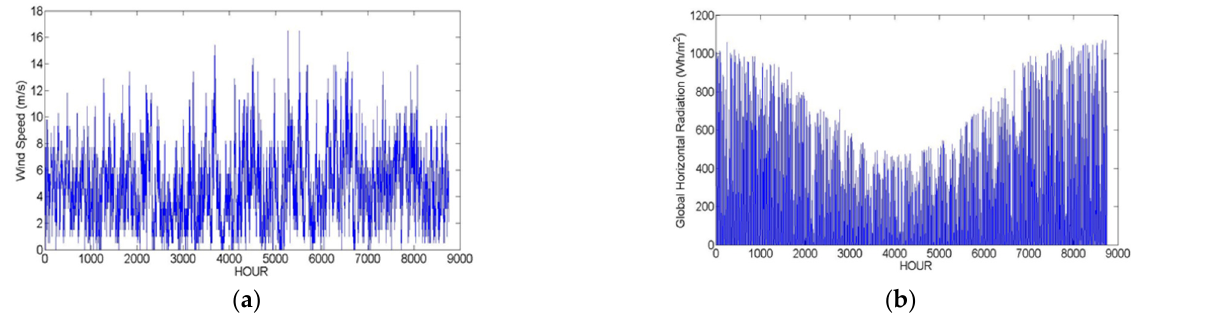
Figure 3. Weather data considered—( a ) hourly wind speed data for a year, ( b ) hourly irradiance data for a year.